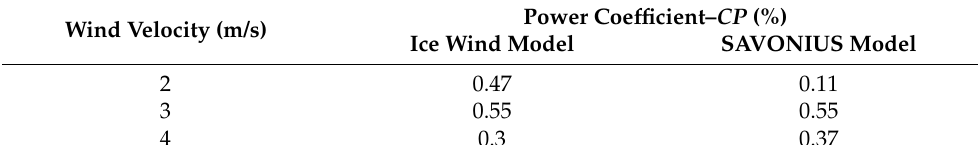
Table 7. Power coefficient values for the experimental rotor models [87].